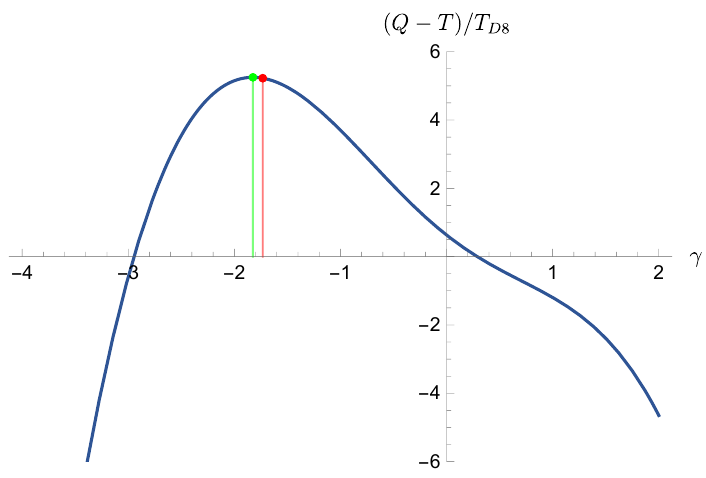
−√ 3 (red). Q > T for the